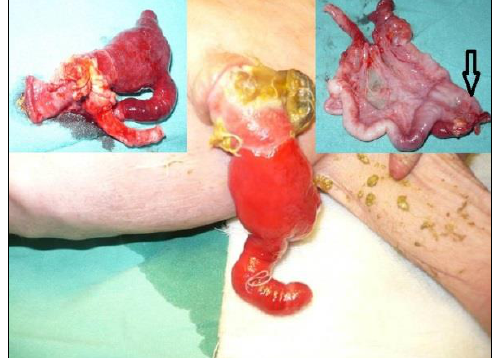
Figure 10: HUC with prolapsed PVID. At operation the prolapsed part could not be reduced back thus necessitating resection and anastomosis. The prolapsed resected gut when reduced forcefully revealed significant length of gut. Arrow shows the PVID. Embryologically, developing intestines are communicated Vitellointestinal tract at the summit of mid